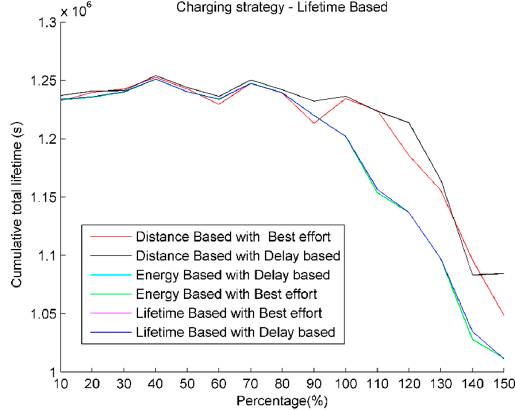
Figure 15. Result of charging quantity effect.